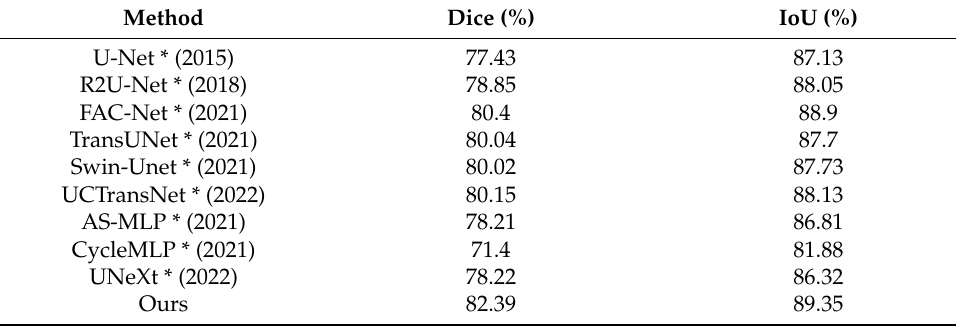
Table 5. ISIC2018 evaluation indicators of each comparison network.